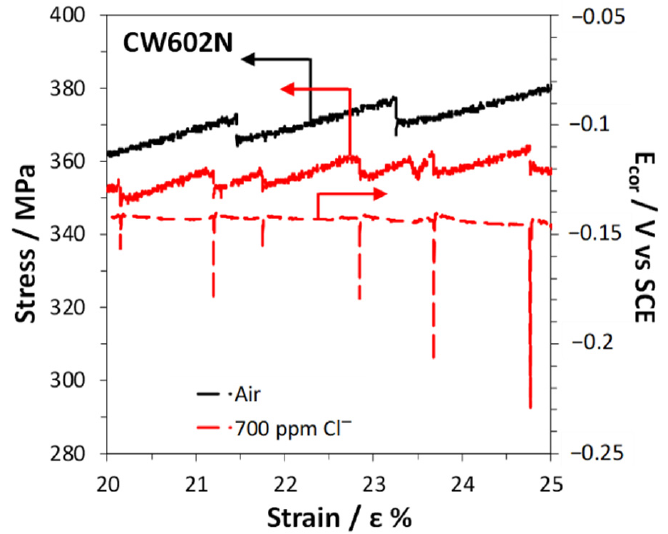
Figure 15. Enlarged view of portions of both the stress vs. strain curves obtained in air and in SDW with 700 ppm chlorides on CW602N and the E cor vs. strain curve of the alloy in the same solution. The fractographic analysis on broken CW602N tensile specimens revealed that the fracture mode moved from ductile to mixed ductile/brittle, on changing the environment for SSRT from air to SDW solutions. In fact, a transition from a ductile dimpled fracture, to fracture surfaces with shallower dimples, associated with some cleavage fracture areas and multiple cracks is documented in Figure 16. The cracks occurred along both TG and IG paths, as also evident in Figure 16a, showing an optical micrograph of a secondary crack section, after microstructural etching.